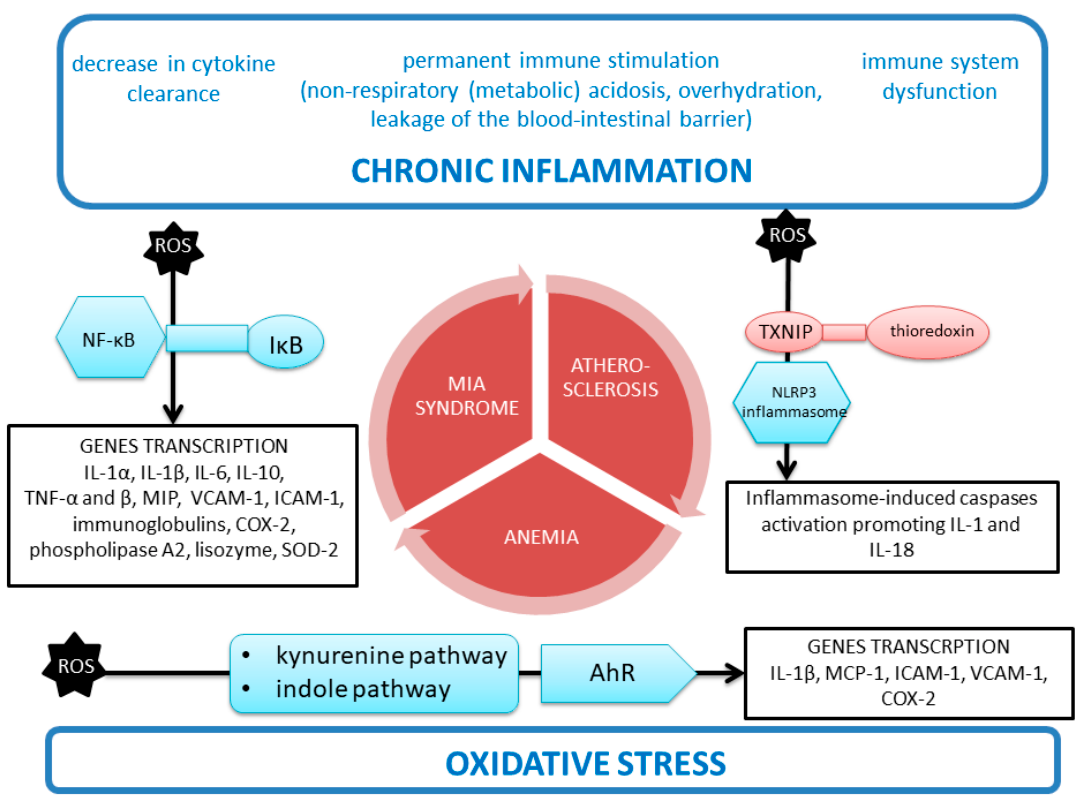
Figure 2. Oxidative stress and chronic inflammatory process in CKD.